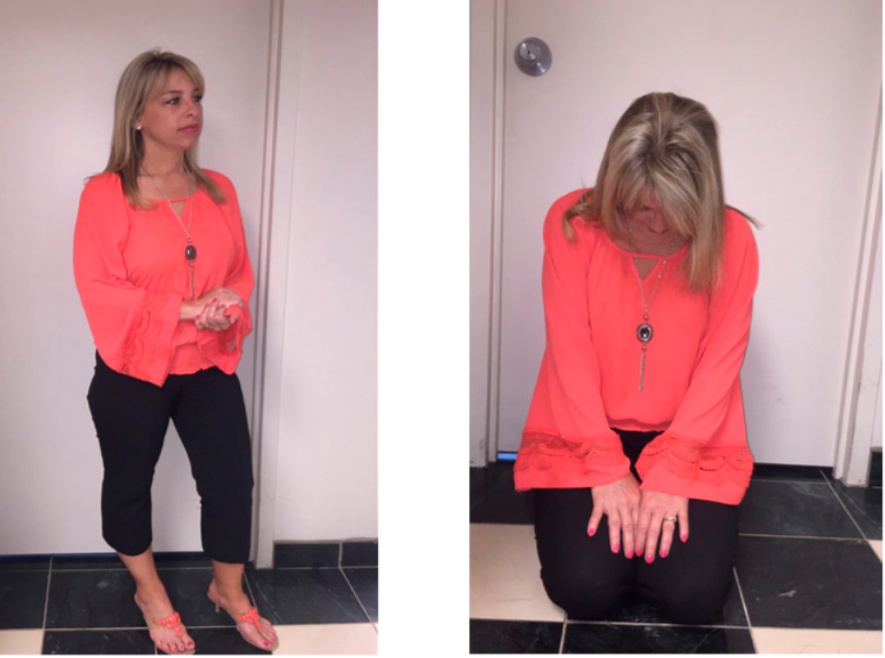
Figure 3. Example of a best ( left ) and worst ( right ) pose.